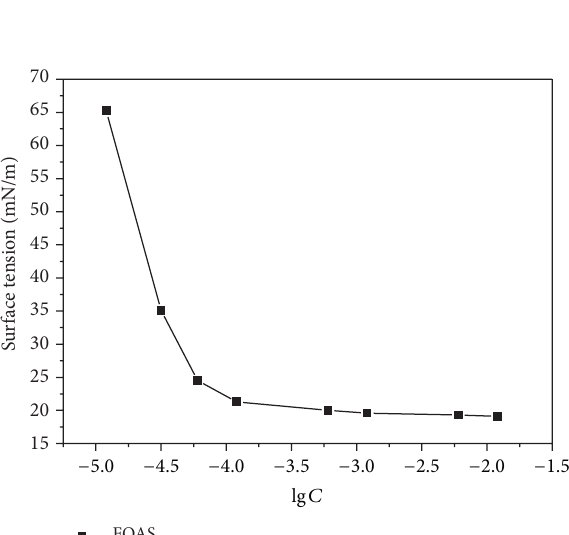
Scheme 2: Synthetic route of FQAS.